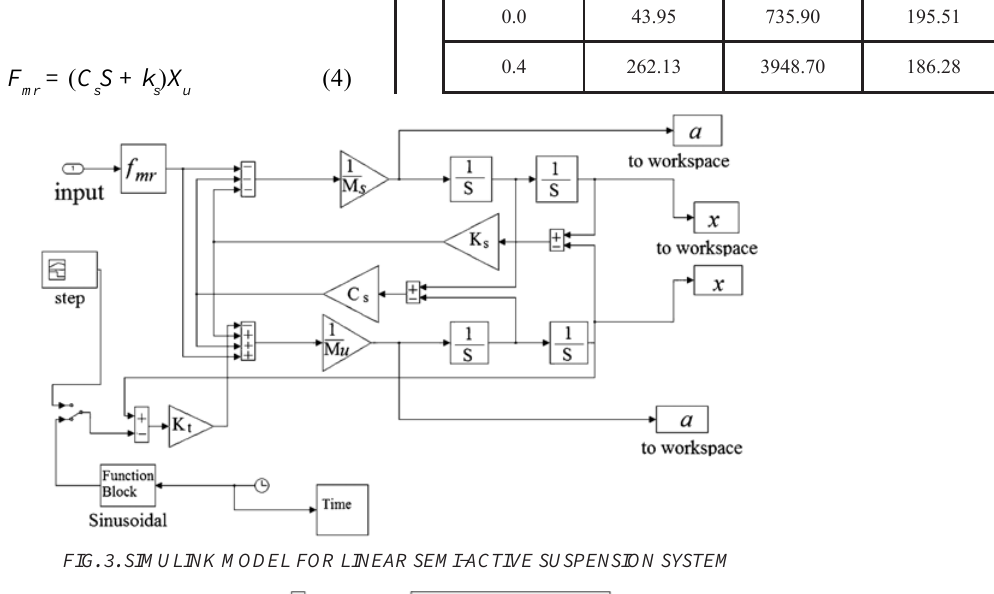
FIG. 3. SIMULINK MODEL FOR LINEAR SEMI-ACTIVE SUSPENSION SYSTEM